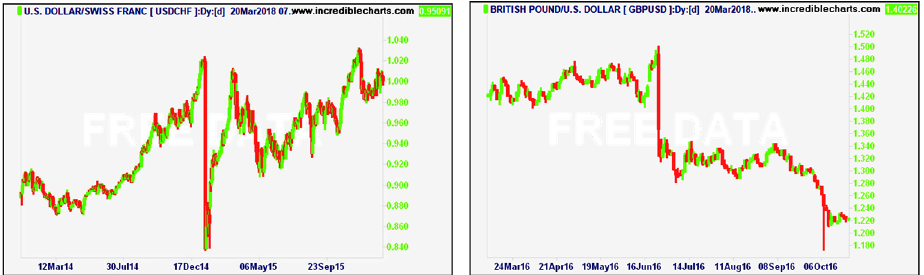
Figure 10. The stock market effect of unexpected events